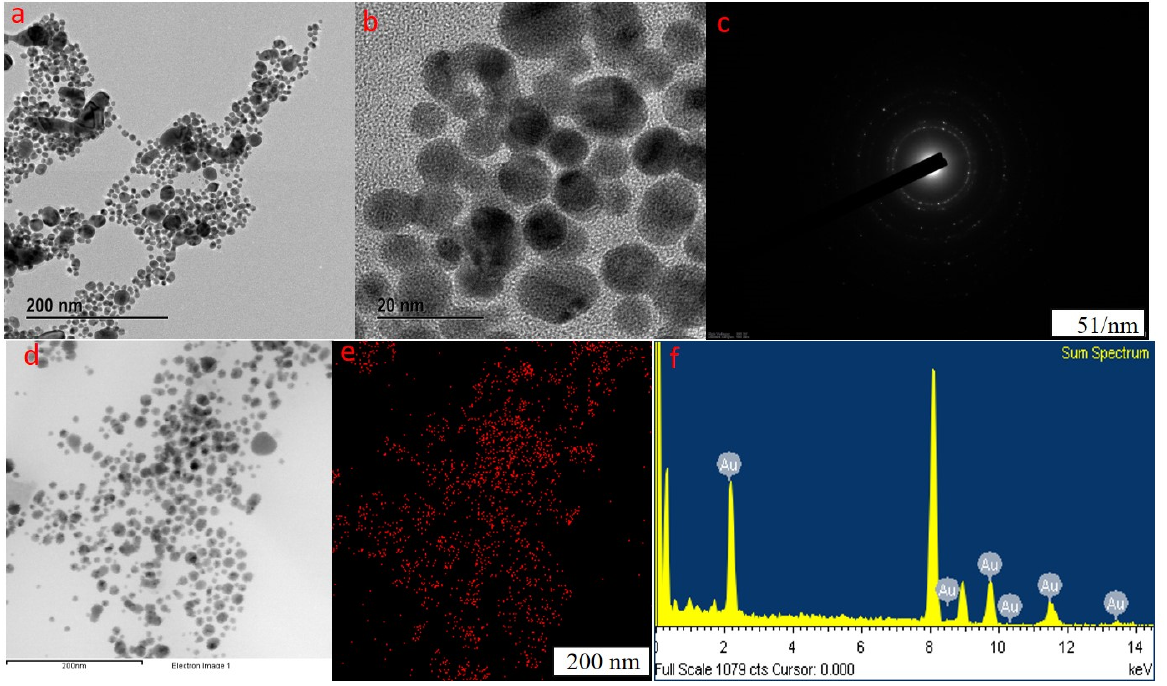
Figure 3. Field emission transmission characterization of GP-AuNPs on electron micrographs showed that GP-AuNPs are predominantly spherical in shape ( a,b,d ), and the selected area